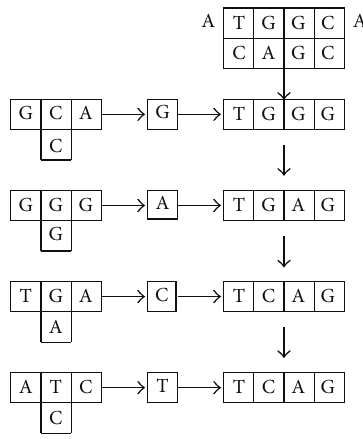
Figure 3: Decryption processes by RT-DNA